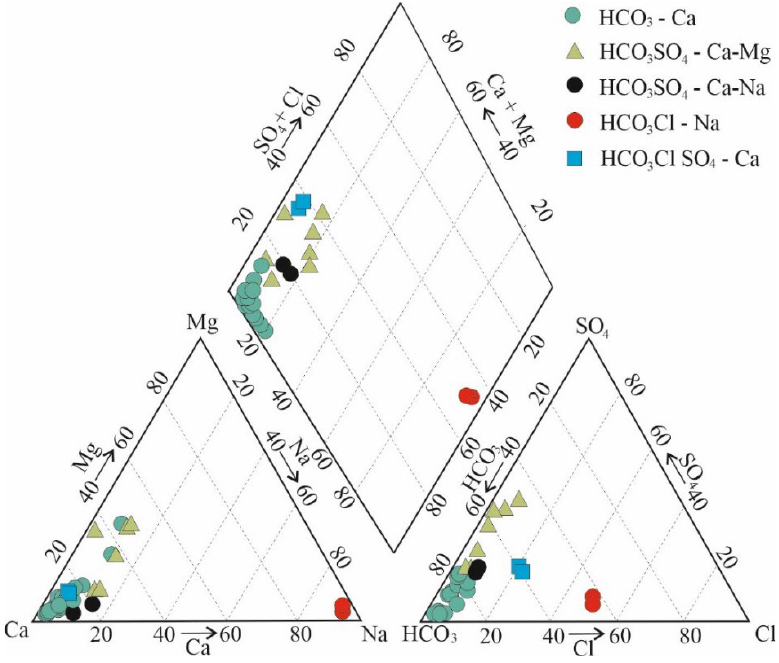
Figure 2. Piper diagram of the groundwater from the Mzymta and Sochi River valleys. Table 1. Chemical composition of macro-elements in groundwater from the Mzymta and Sochi River valleys.